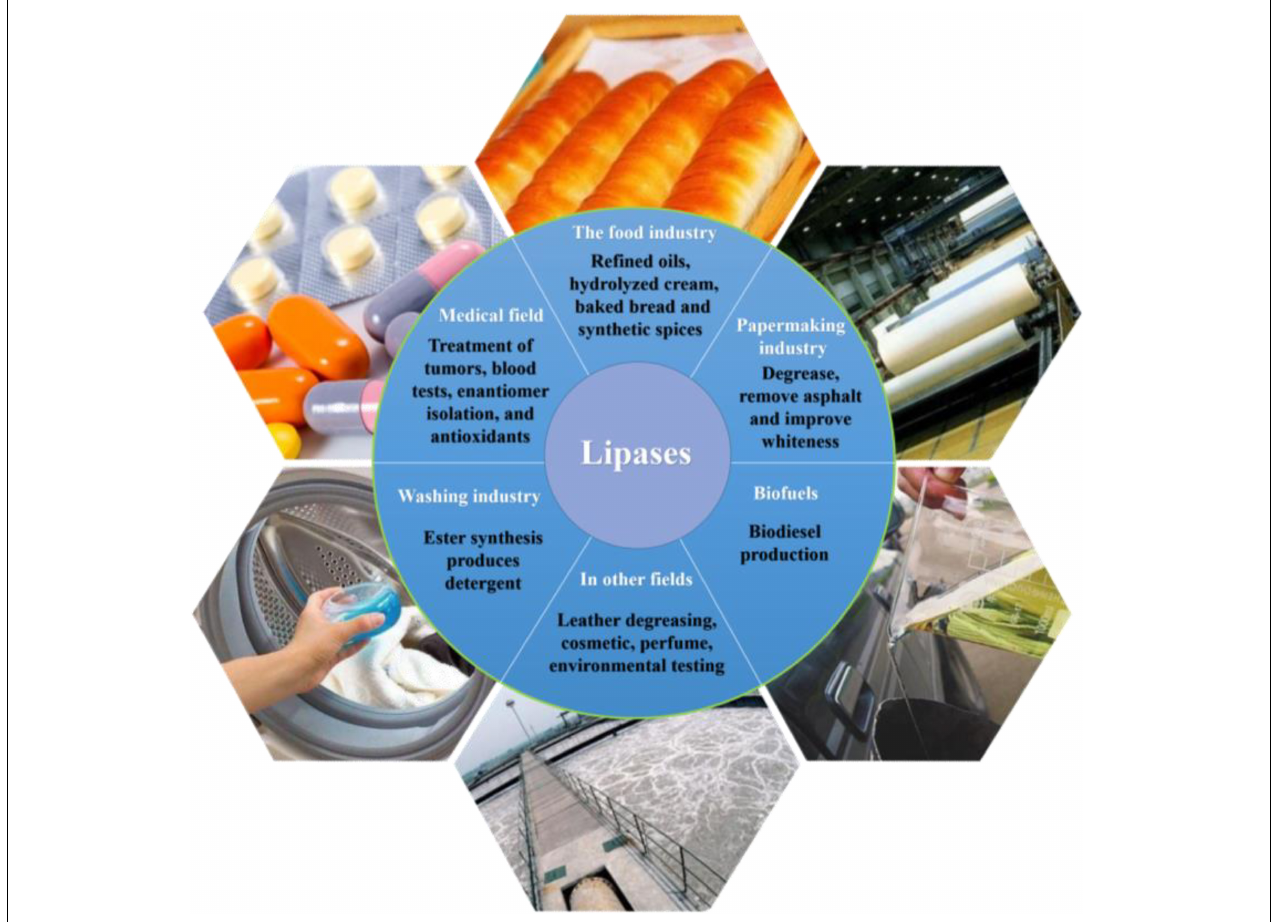
FIGURE 1 | Various industrial applications that feature microbial